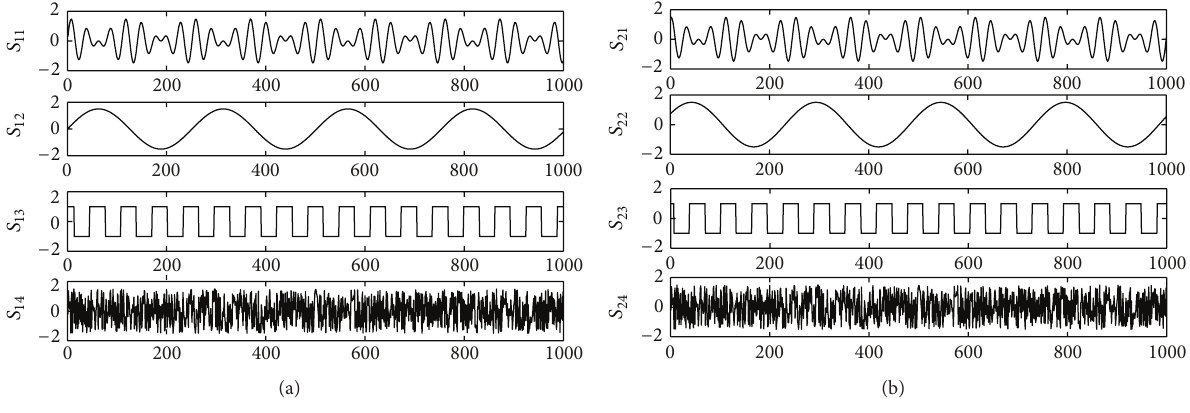
Figure 1: The four simulated source signals: (a) for X ; (b) for Y .